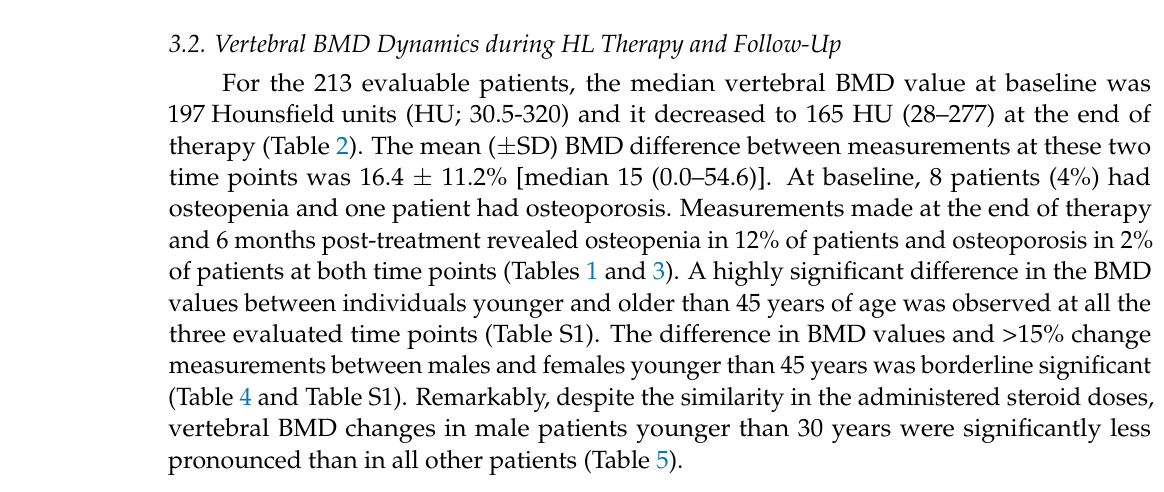
Table 3. Patient BMD evaluated at the end of treatment and 6 months